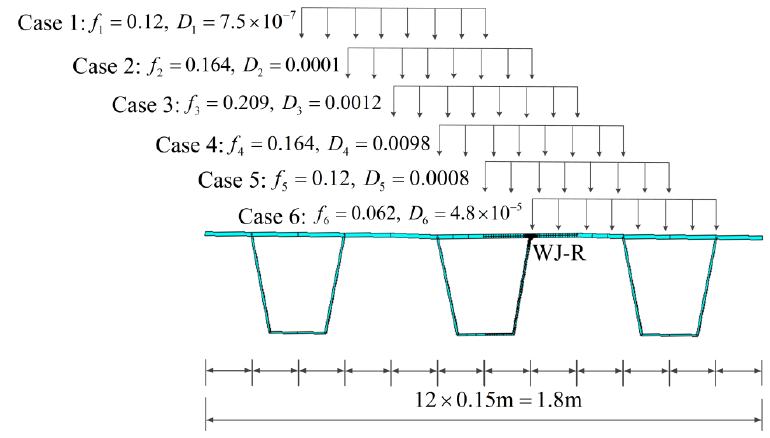
Figure 18. Damage under six load cases.